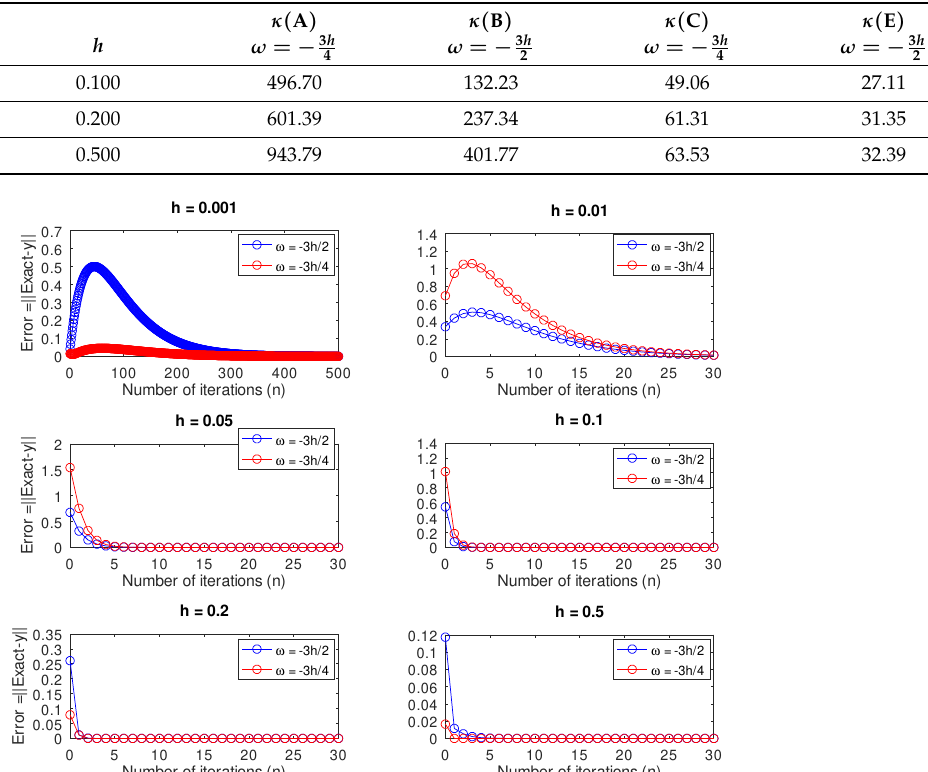
3 h , by solving an underdetermined 3 h 2 by solving an under-determined − 2 −